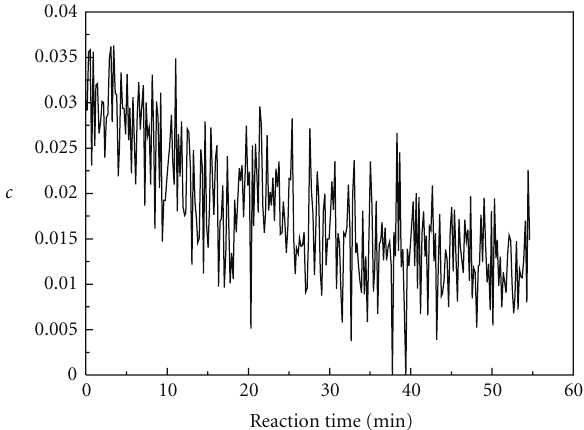
Figure 13: The curve of intermediate 1 relative concentration ver- sus reaction time.